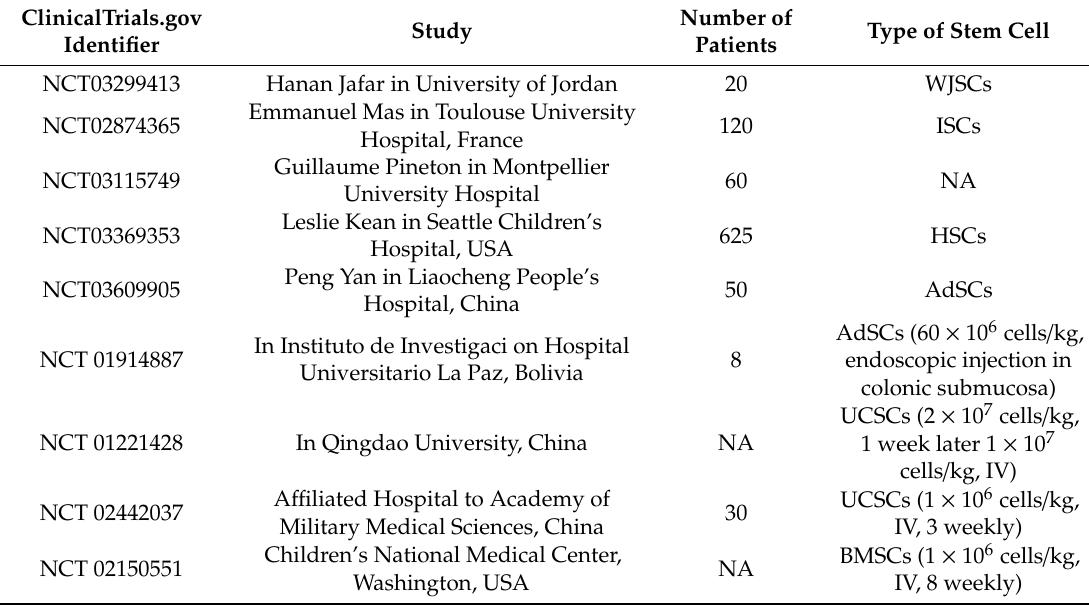
Table 3. Registered phase I / II clinical trials in the treatment of UC by MSCs.